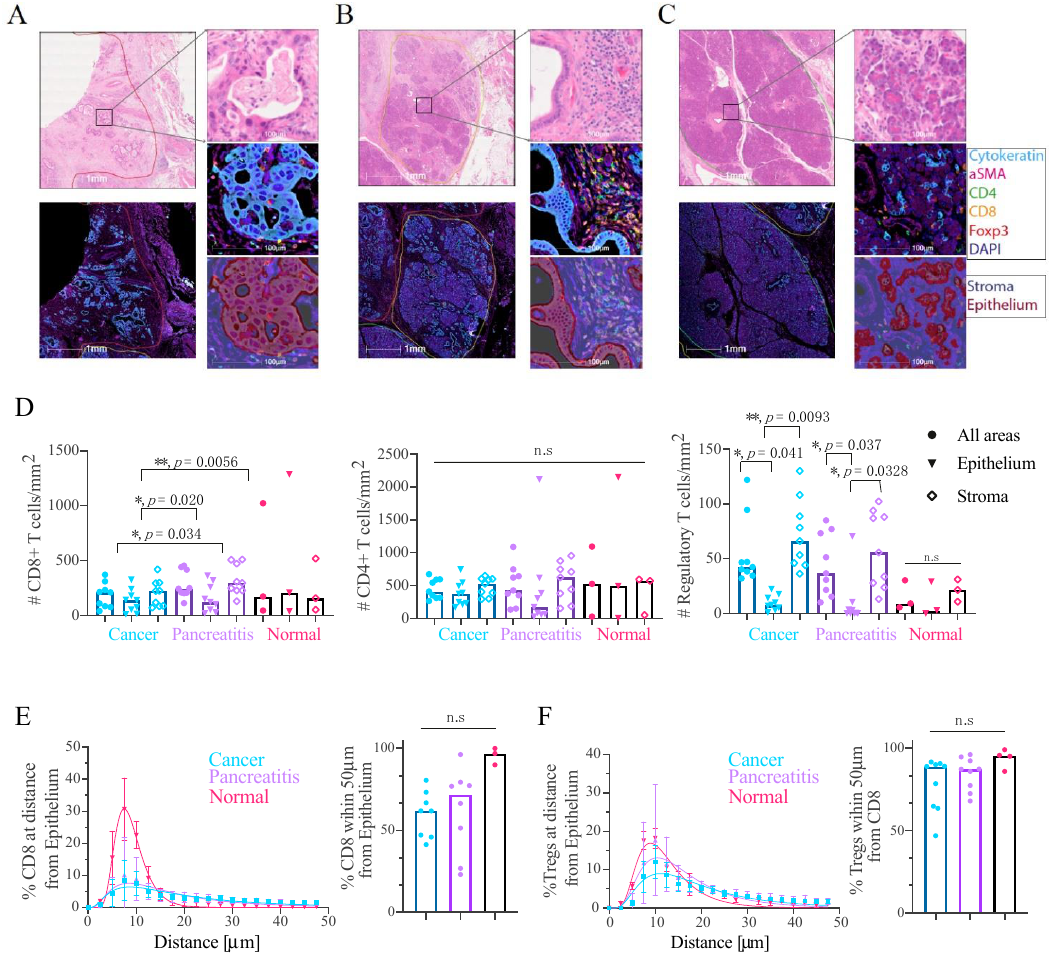
Figure 4. Multiplex imaging of T-cell distribution within PDAC tumours identifies a stroma restricted Treg compartment. ( A ) 2× magnification (left) of a cancer region showing H&E (top) and immunofluorescence (bottom). 40× magnification (right) of a region from (left) showing H&E staining (top), the fluorescence signal (middle) and the region classification into epithelium and stroma (bottom). ( B ) As in ( A ) for a region exhibiting pancreatitits. ( C ) As in ( A ) for a normal pancreas region. ( D ) Infiltration of CD8 + T-cells (left), CD4 + T-cells (middle) and Tregs (right) into the tissue (Cancer, Pancreatitis and Normal), as well as sub-tissue architectural distribution between the epithelium-rich and stroma-rich areas. Mixed-effect ANOVA with Tukey’s correction. ( E ) Proximity analysis of CD8 + T-cells distance distribution within 50 µm of epithelial cells fitted using a lognormal distribution with geometric means and R 2 as follows: Cancer: 17.21 µm, 0.80; Pancreatitis 14.55 µm, 0.79; Pancreas: 8.46 µm, 0.99. ( F) Proximity analysis of Treg distance distribution within 50 µm of CD8 + T-cells, fitted using a lognormal distribution with geometric means and R 2 as follows: Cancer: 16.75 µm, 0.84; Pancreatitis 14.28 µm, 0.82; Pancreas: 11.24 µm, 0.92. Scale bars: 1 mm (for 2× magnification) and 100 mm (for 40× magnification).